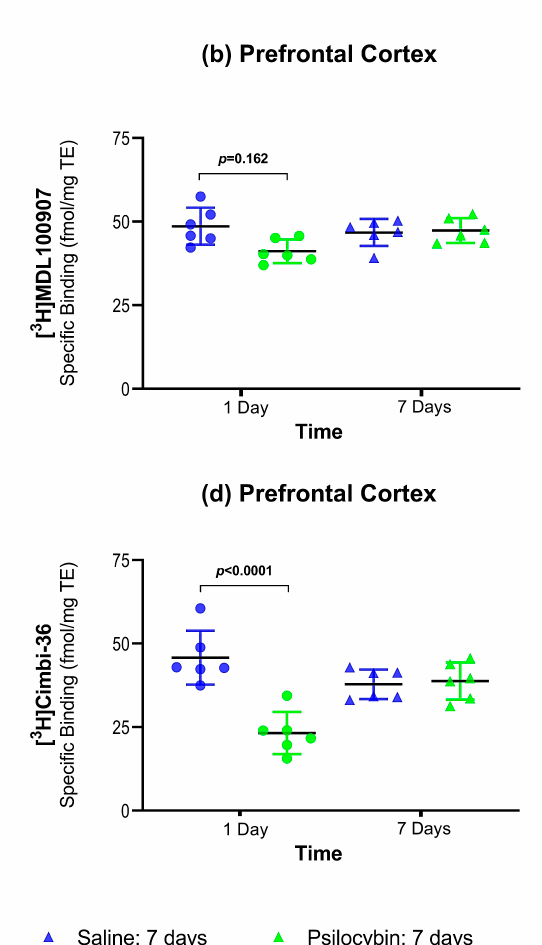
Figure 2. Group-wise comparison of 5-HT 2A R density (mean ± SD) as measured with [ 3 H]MDL100907 and [ 3 H]Cimbi-36 in the hippocampus ( a , c ) and PFC ( b , d ) using